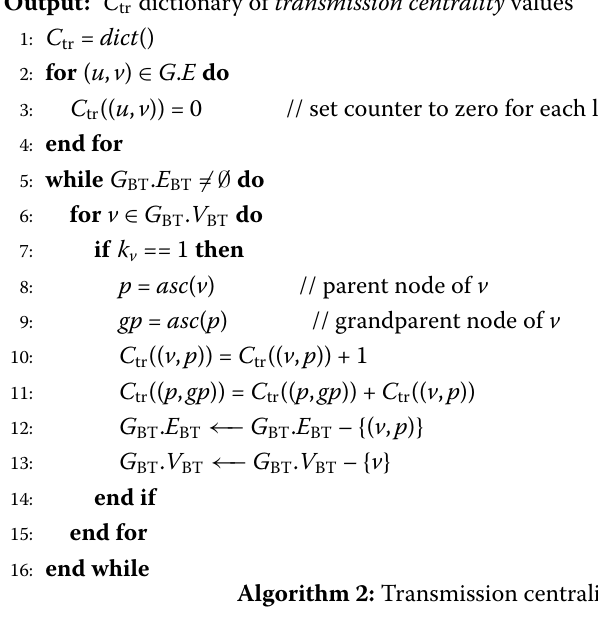
Algorithm 2: Transmission centrality